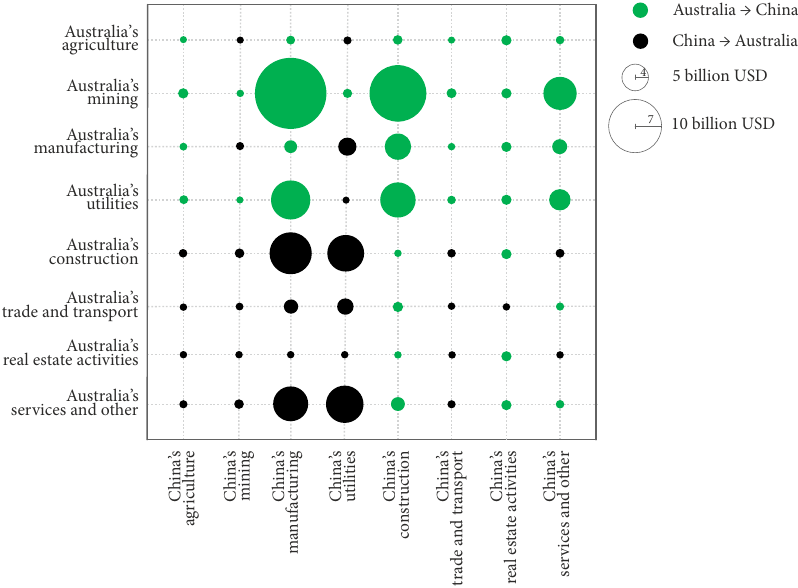
Figure 3. Net CO 2 emissions in inter-industrial trade between Australia and China in